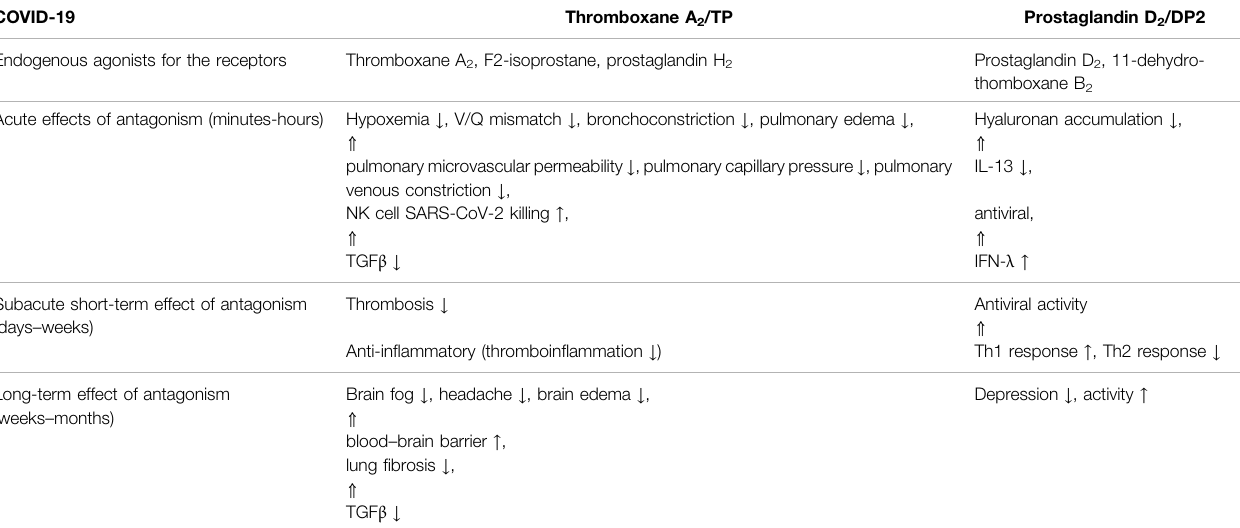
TABLE 3 | Proposed effect of antagonizing thromboxane A 2 /TP and prostaglandin D 2 /DP2 signaling by ramatroban in patients with COVID-19.